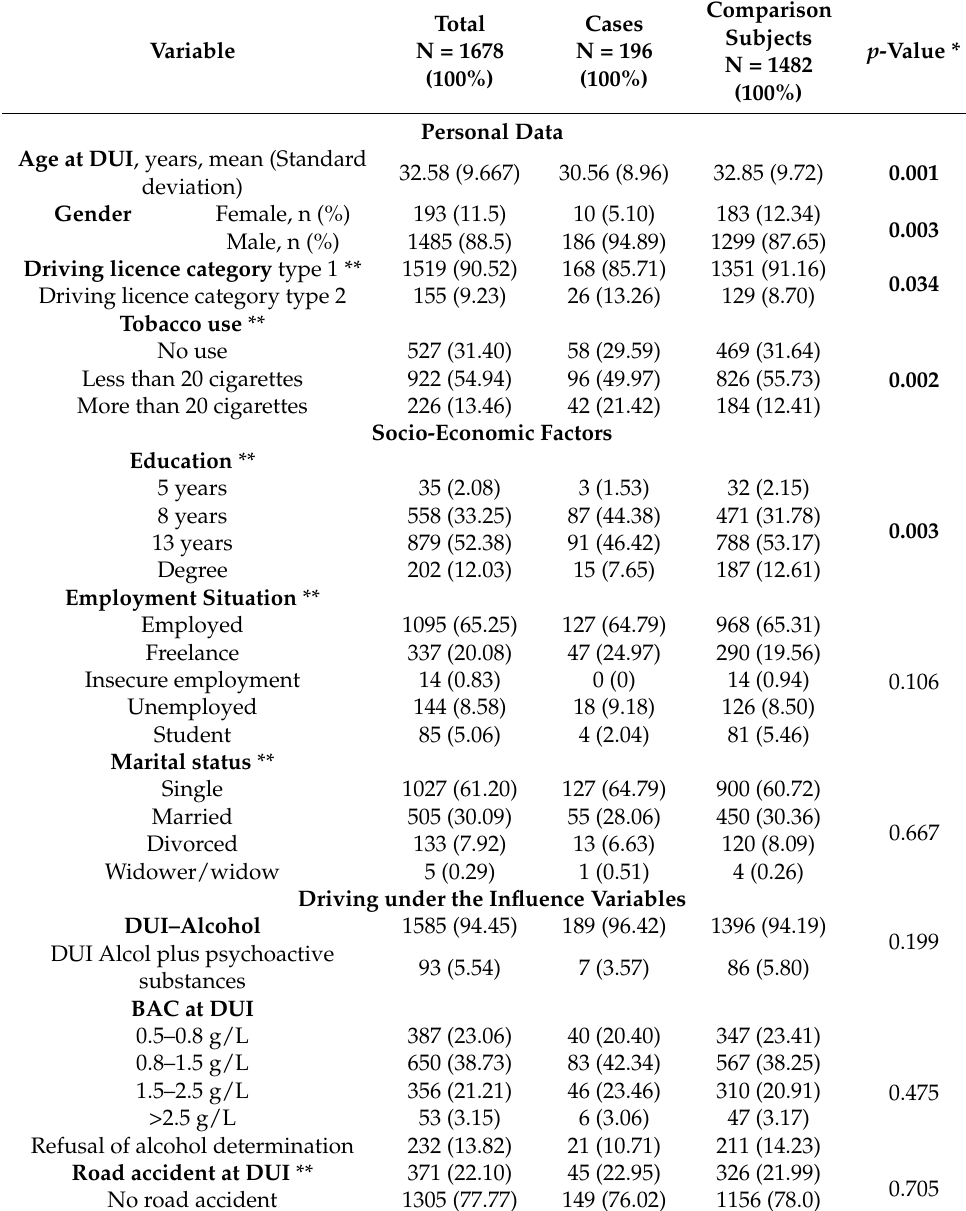
Table 2. Personal data, socio-economic factors, and conditions at DUI in cases and the comparison